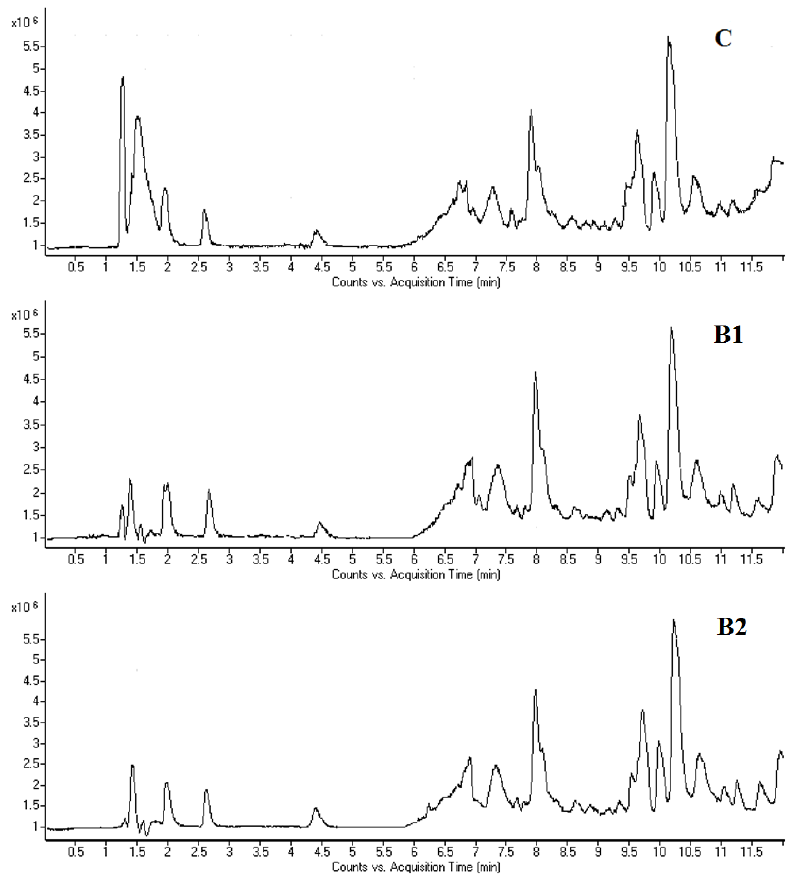
Figure 4. Total ion chromatograms (TICS) of plasma samples obtained from the control group ( C ), and benzene 1 ( B1 ) and benzene 2 groups ( B2 ) of male C3H/He mice following 7 days of benzene exposure, using LC/MS (positive